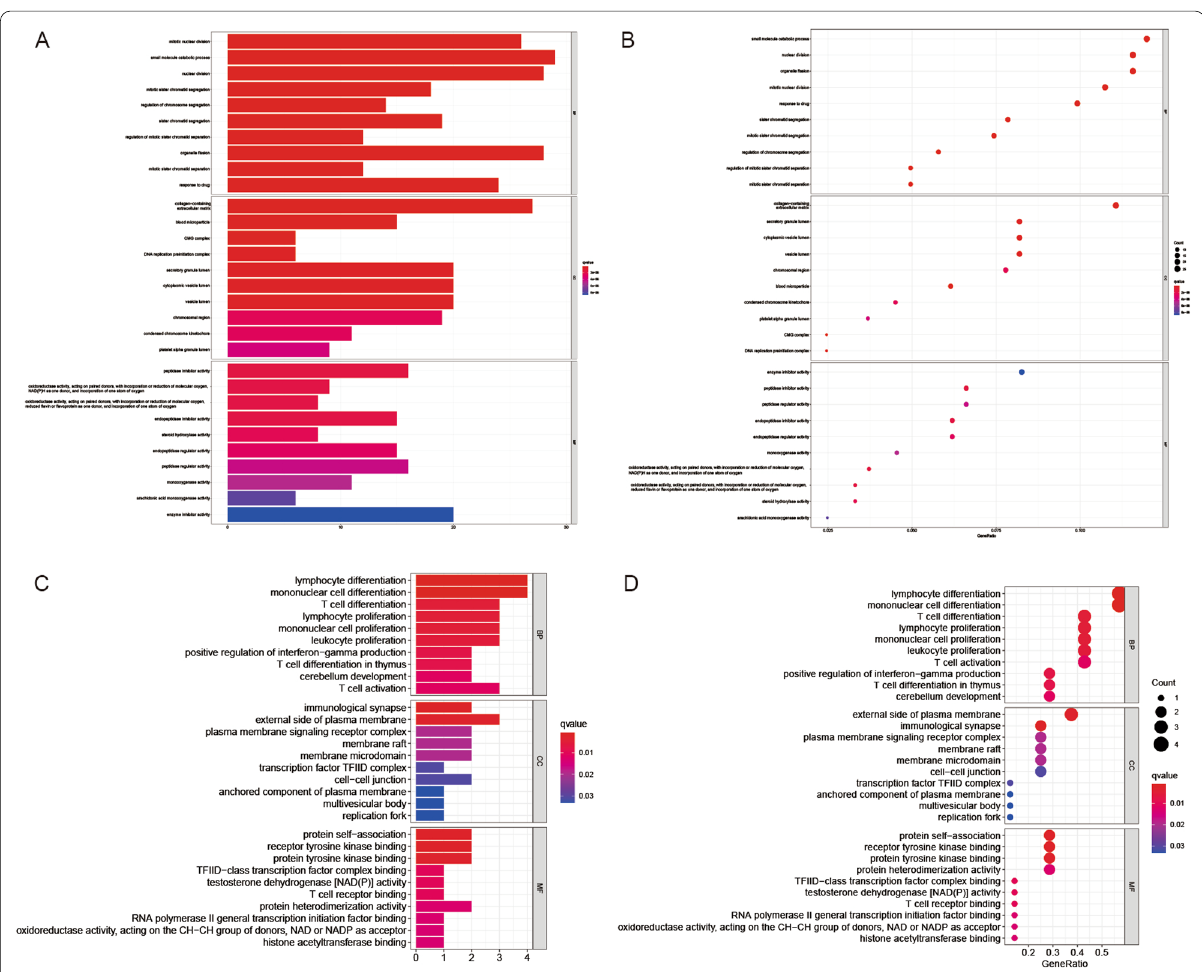
Fig. 6 Functional analysis based on the PRGs between the two-risk groups in the TCGA and GEO cohort. A Bubble graph for GO enrichment in the TCGA cohort (the larger bubble means the more genes enriched, and the increasing depth of red means the differences were more obvious; q-value: the adjusted p value). B Barplot graph for KEGG pathways in the TCGA cohort (the longer bar means the more genes enriched, and the increasing depth of red means the differences were more obvious). C Bubble graph for GO enrichment in the GEO cohort. D Barplot graph for